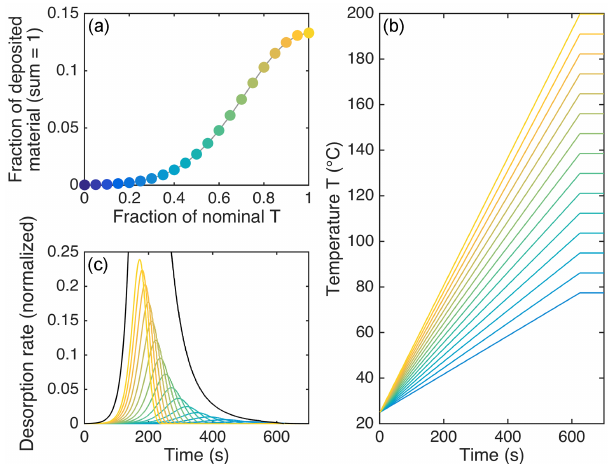
Figure 4. Illustration of the assumptions behind the model results in Fig. 3c. (a) shows the fractions of deposited material (on the or- dinate) that were each assumed to be exposed to a fraction of the nominal desorption temperature (on the abscissa). This function is Gaussian with a standard deviation of 0.28. (b) shows the respec- tively assumed temperature profiles, except for the lowest six, which we neglected. (c) shows the respective desorption rates as a func- tion of time, as well as the sum of all rates (black; peaking at 1), illustrating how the assumptions here lead to a tail in the sum ther- mogram (cf. Fig. 3d). In all panels, the color scheme reflects the maximum desorption temperature for each fraction or profile, from 200 ◦ C (lightest yellow) to 79 ◦ C (darkest blue in b and c ) or 25 ◦ C (darkest blue in a